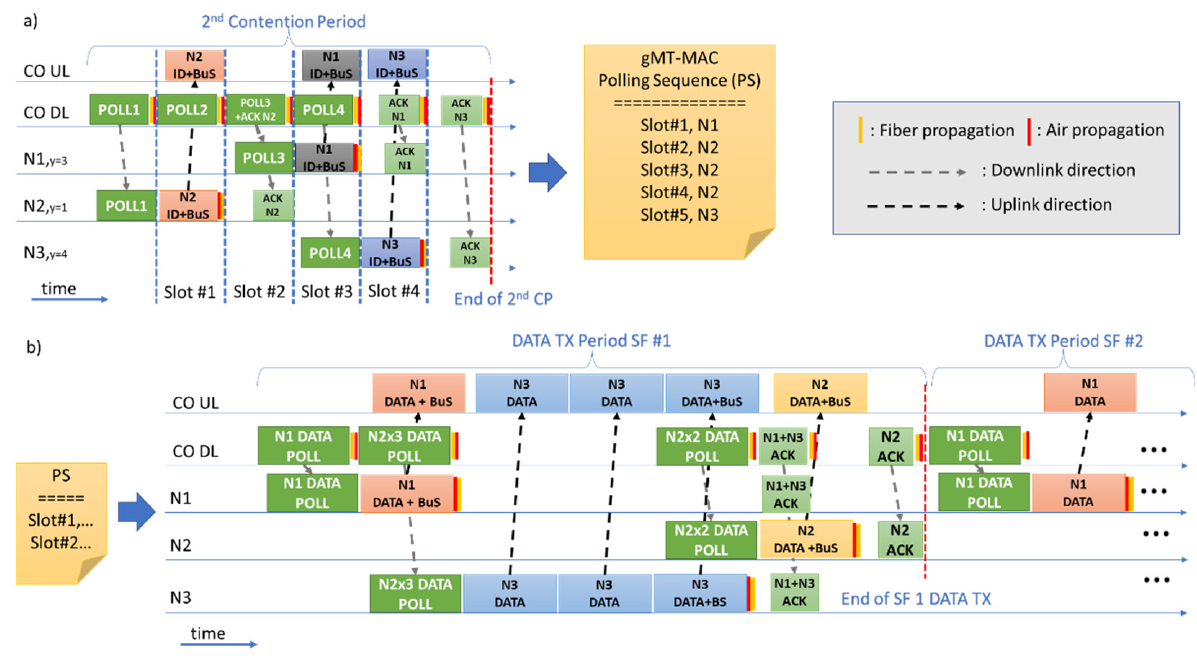
Figure 3. Operation of the legacy gMT-MAC protocol. ( a ) An example of the 2nd Contention Period operation for an RAU with 3 connected nodes. Each node chooses randomly the slot to transmit its MAC address (ID) and Buffer Status (BuS). If there are no collisions, the CO transmits an ACK packet acknowledging the correct reception of the ID + BuS packets. Based on the latter, the CO constructs the Polling Sequence (PS) of the next SF. ( b ) DATA_TX period example for an RAU with 3 nodes, with N1 having 1 packet to transmit, N2 having two packets to transmit, and N3 having 3 packets to transmit.